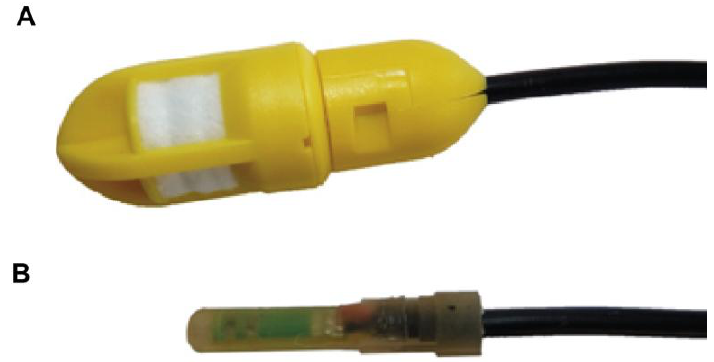
Figure 1. ( A ) PlantCare sensor (diameter 15 mm). ( B ) PlantCare sensor without box and synthetic felt.